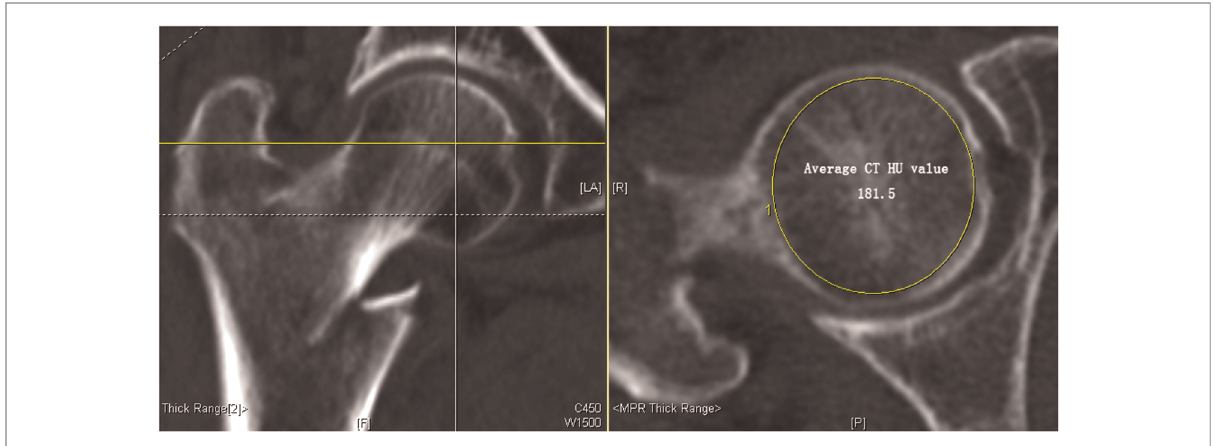
FIGURE 1 The methods of measuring computed tomography (CT) Houns fi eld units (HU) values of the femoral head. A single axial femoral head level was selected. The level included the last slice of femoral neck – fi rst slice of femoral head combination. A spherical region of interest (ROI) was drawn with the largest possible diameter excluding the cortical bone in femoral head and average HU value (181.5 HU) was noted. CT, computed tomography; ROI, region of interest.